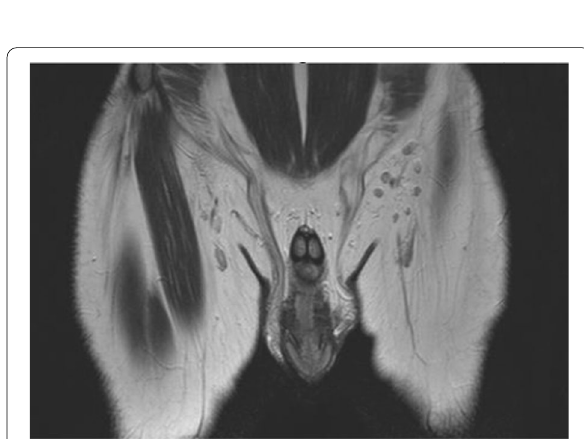
Fig. 5 MRI axial T2 weighted image small soft tissue nodule noted in the region of left testis and at the tip of left spermatic